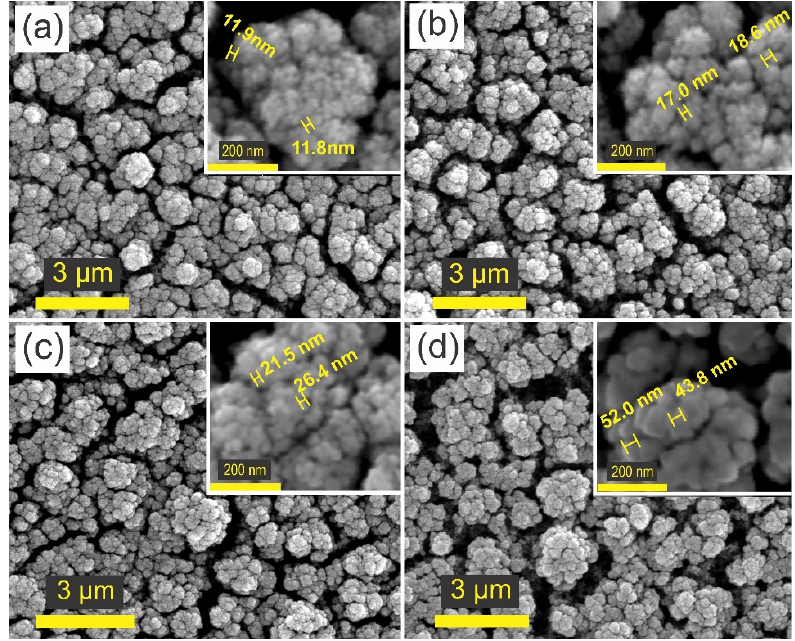
Figure 3. Surface morphology of the: ( a ) As-synthesized amorphous tungsten oxide (a-WO 3 ) film, a-WO 3 film annealed at ( b ) 100 °C, ( c ) 300 °C, and ( d ) 500 °C.